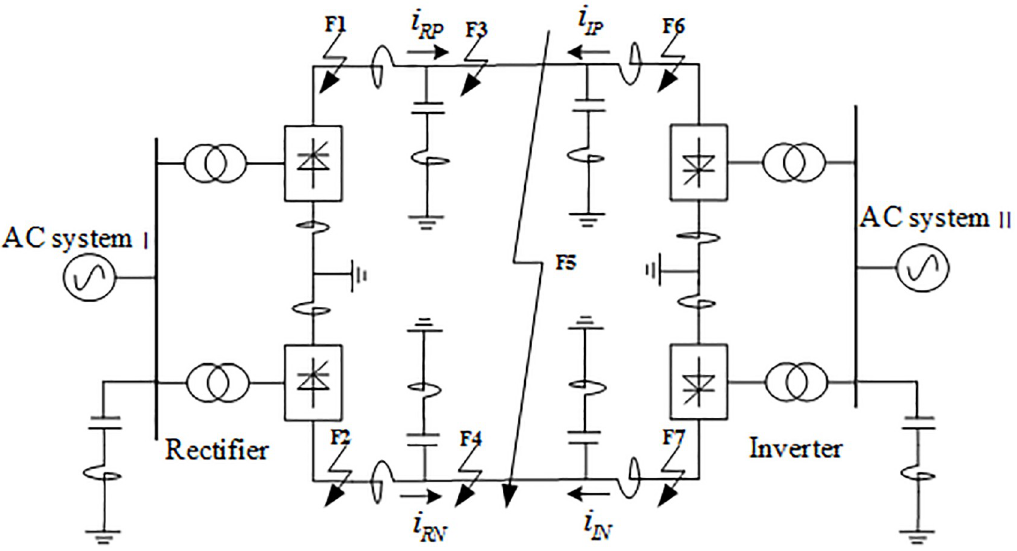
Fig 1. Bipolar HVDC transmission system structure.